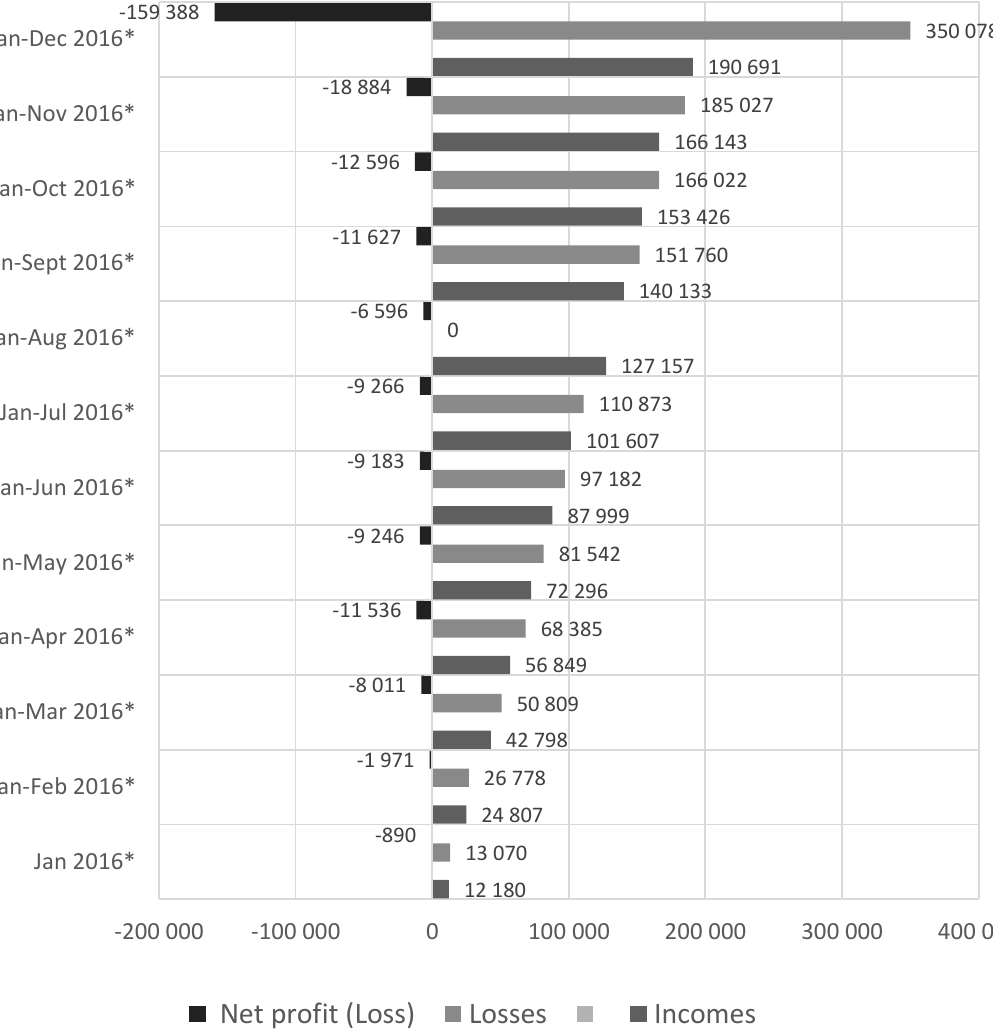
Figure 3. Incomes, expenses and profits of Ukrainian banks in 2016